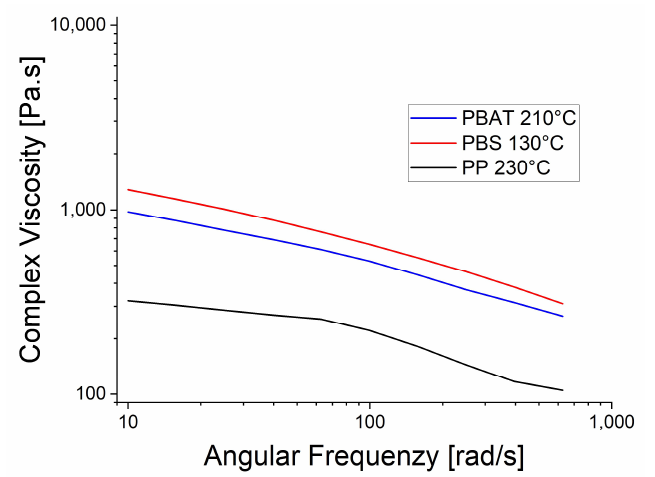
Figure 6. Rheology of three biopolymers at the spinning temperature.